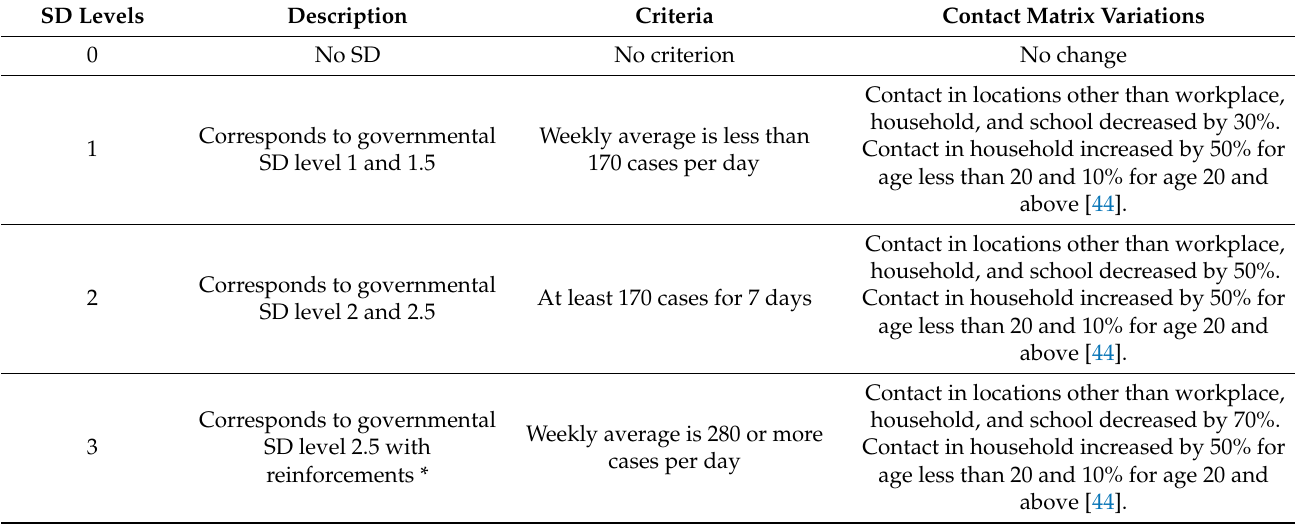
Table 3. Description of the modified social distancing (SD) in